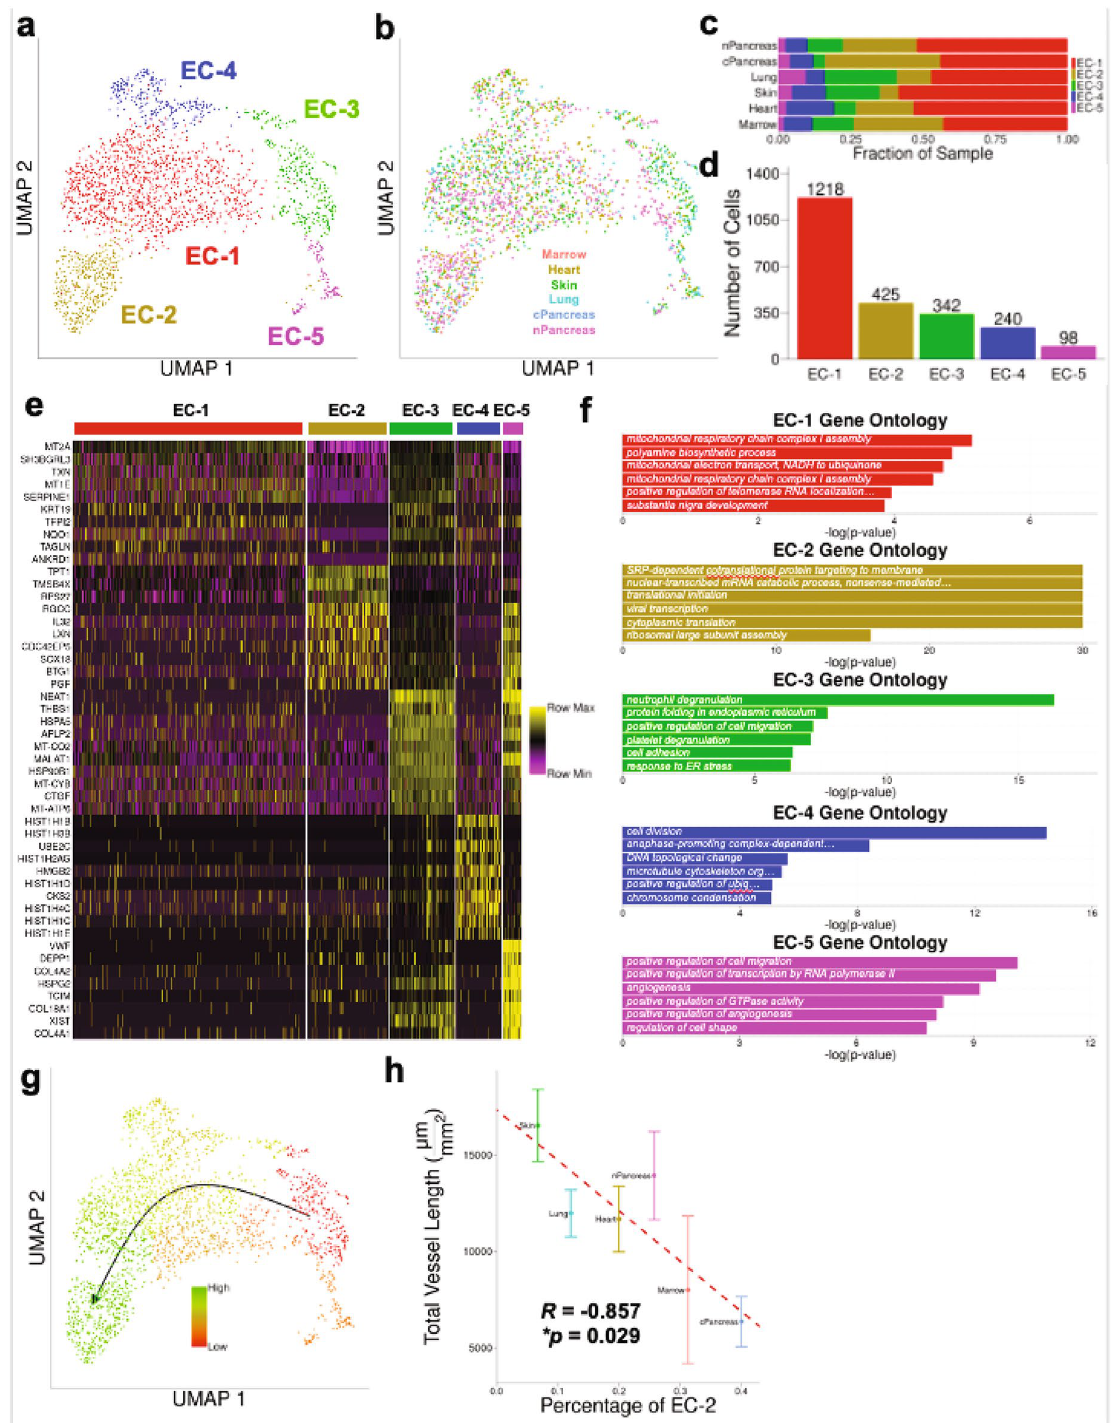
Figure 4. ECs isolated from 3D in vitro microvessel networks separate into distinct clusters with unique transcriptomic profiles. ( a ) UMAP plot of renormalized ECs from the 3D in vitro microvessel network dataset shows ECs separate into 5 distinct clusters (EC-1, EC-2, EC-3, EC-4, and EC-5). ( b ) UMAP plot of renormalized ECs from the 3D in vitro microvessel network dataset grouped by 3D in vitro microvessel network type. ( c ) Grouped bar chart to show relative percentages of each EC cluster per 3D in vitro microvessel network type. ( d ) Bar chart of total number of cells per EC cluster. ( e ) Heatmap of top 10 DEGs for each EC cluster. ( f ) Top 6 most significantly overexpressed GO biological process terms based on top 20 DEGs for each EC cluster. ( g ) Pseudotime values of 3D in vitro EC dataset as determined by Monocle3, mapped onto the UMAP dimensionality reduction of the renormalized ECs (green = late/ high pseudotime, red = early/low pseudotime). ( h ) Correlation of the total vessel length measured for each 3D in vitro microvessel network (Fig. 1) compared with the relative percentage of EC-2 in each 3D in vitro microvessel network ( c ). Error bars represent 1 standard deviation above and below the mean total vessel length. Pearson correlation coefficient R = − 0.857 with associated p =